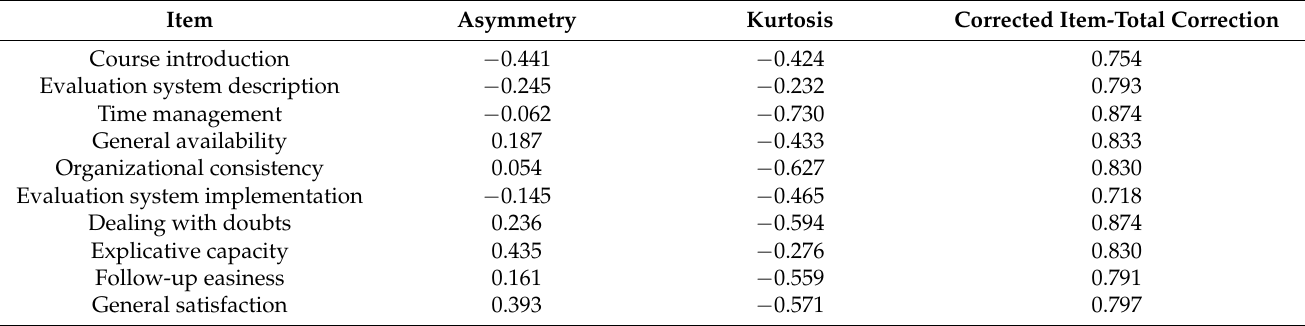
Table 1. Asymmetry and kurtosis coefficients and corrected item-total correlation